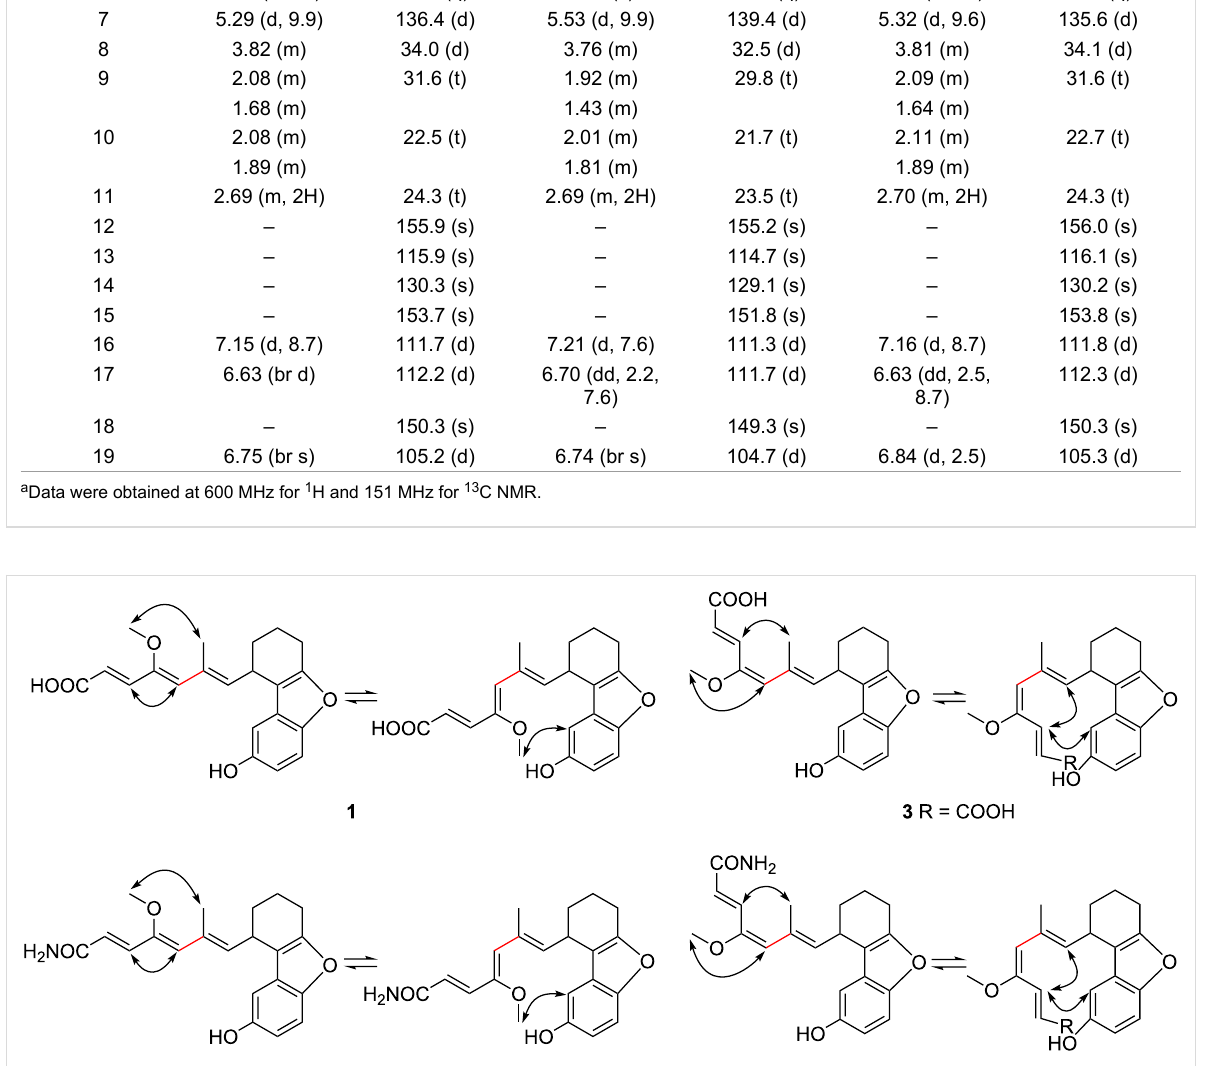
Figure 2: Selected NOESY correlations of compounds 1 , 3 and 4 , 5 .